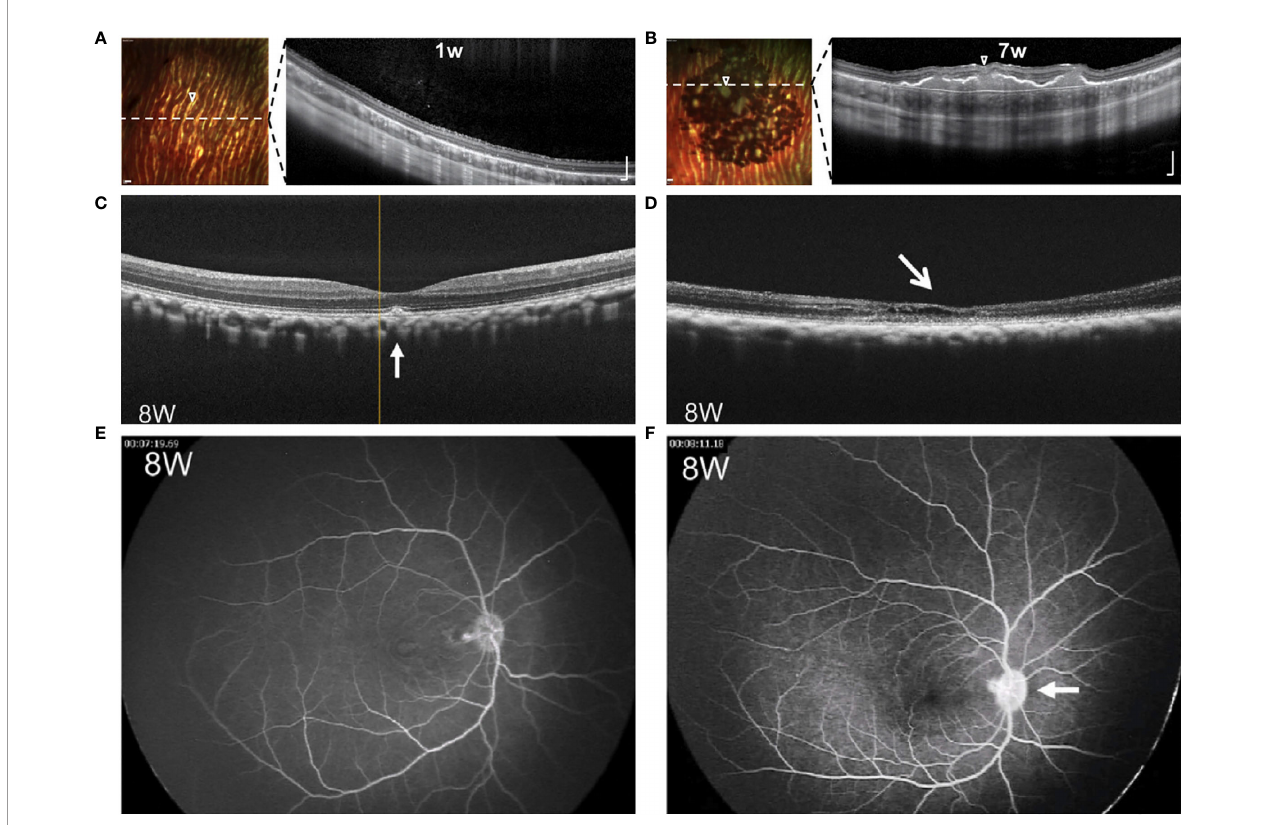
FIGURE 3 | Comparative images of RPE grafts with and without rejection. (A, B) Multicolor-confocal scanning laser ophthalmoscopy and corresponding OCT following subretinal injection of RPE cell suspension. Homogenous monolayer leads to clumping of pigment over 1-7 weeks. Dashed line indicates plane of corresponding OCT, where subretinal mass is seen along with choroidal thickening under the graft site. Modi fi ed from Petrus-Reurer 2020 (35). (C, D) OCT eight weeks following transplant of RPE suspension. Compared to non-rejected transplant (C) , retina with rejected graft (D) shows atrophy of the neuroretina